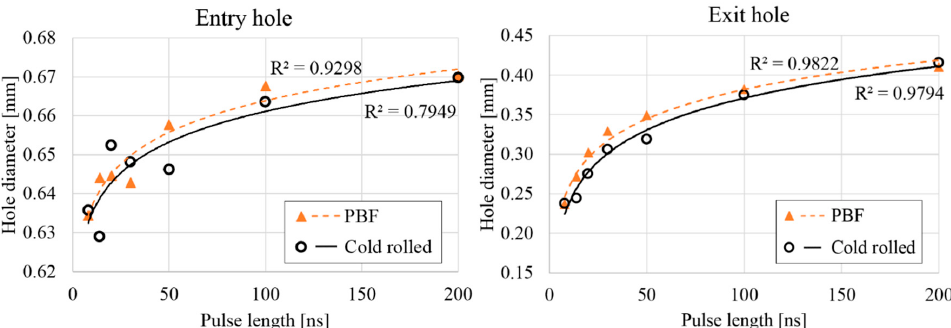
Figure 6. Measured entry and exit hole diameters for the laser drilled holes.